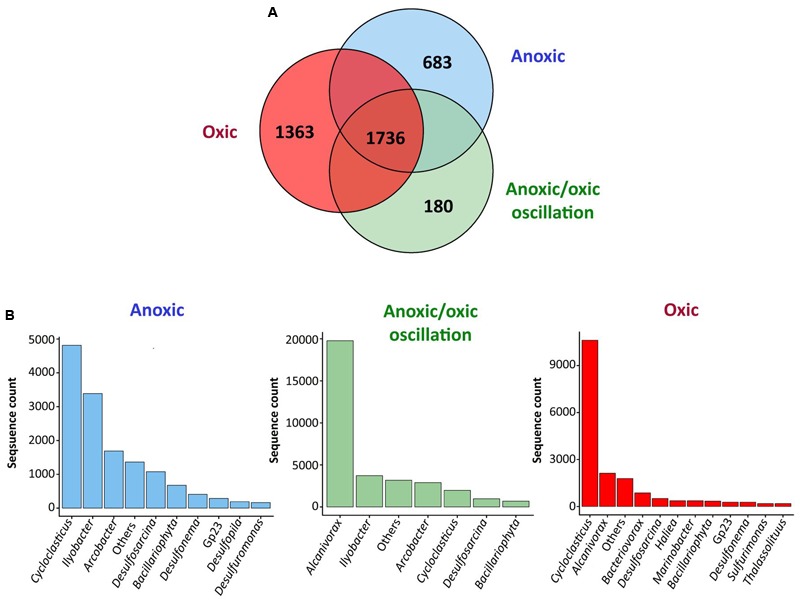
Comparison of bacterial communities from the different conditions. (A) Venn diagram showing the number of shared OTU97s between all conditions and the number of specific OTU97s for each condition. (B) Relative abundances of the specific OTU97s for each condition. The analysis was performed at the genus level applying a threshold similarity of 97% for OTU identification (OTU97s). The analysis includes all samples covering the whole incubation period. The analysis is based on biological triplicates. The other∗ group combine the genera related to rare OTUs that are represented by less than 1% of total sequences per sample. The relative abundances of the OTU97s belonging to the “other group” are presented in Supplementary Figure 4.